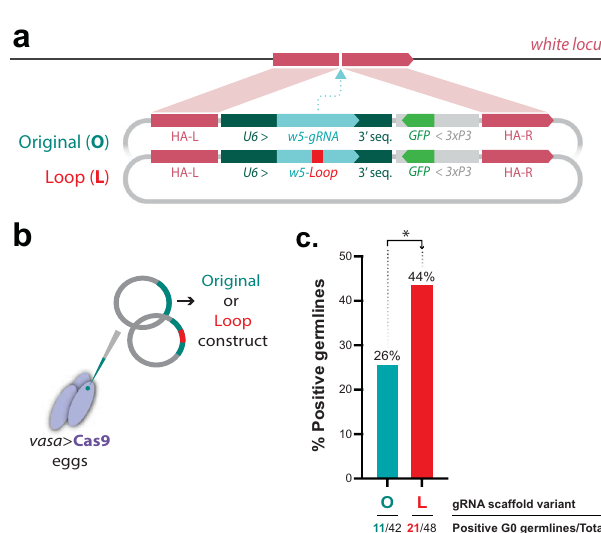
Fig. 4 Evaluation of transgenesis ef fi ciency in Drosophila melanogaster using gRNA scaffold variant. a Constructs designed for Drosophila transgenesis experiments. Both constructs contain the w5 -gRNA driven by the Drosophila U6:3 promoter and are marked with GFP fl uorescence to identify positive transformants. Two homology arms fl ank the gRNA element to facilitate HDR-mediated transgene integration into the Drosophila genome. The two constructs differ only in their gRNA scaffold for the presence of either the “ Loop ” modi fi cation or the control, “ Original ” construct. b Both constructs were injected separately into a Dm-vasa > Cas9 line to ensure Cas9 expression in the germline. c Germline transformation rates were calculated by dividing the number of G0 independent single-pair crosses giving transformants (GFP + ) by the total number of G0 crosses performed. A one-tail randomization test for a difference in proportions was performed to determine whether the “ Loop ” scaffold variant caused an increase in transgenesis when compared to the “ Original ” gRNA ( p value =